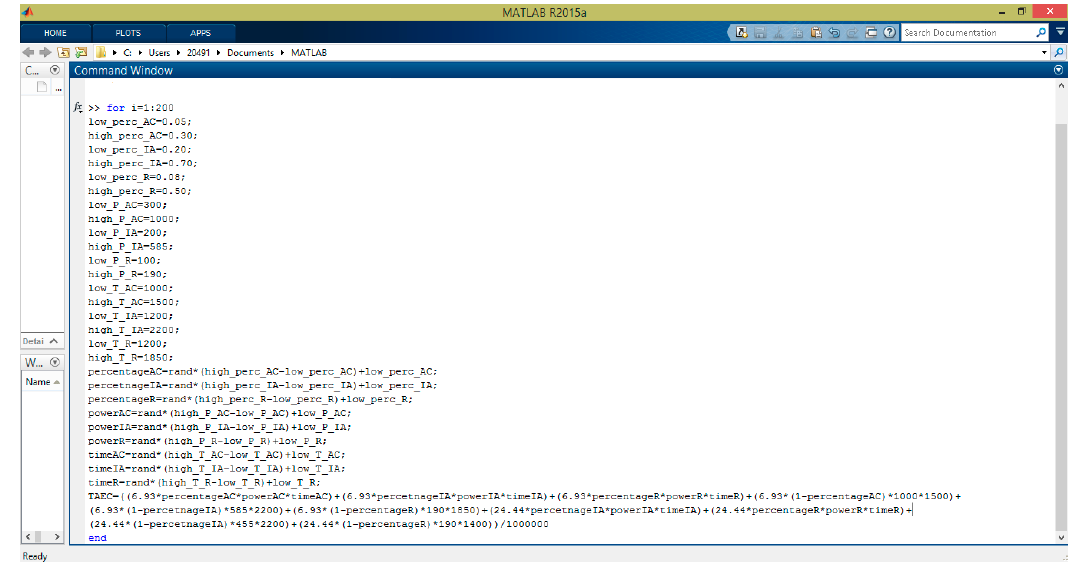
Figure 4. Program code for calculating the annual electricity consumption of the Mexican residential sector.